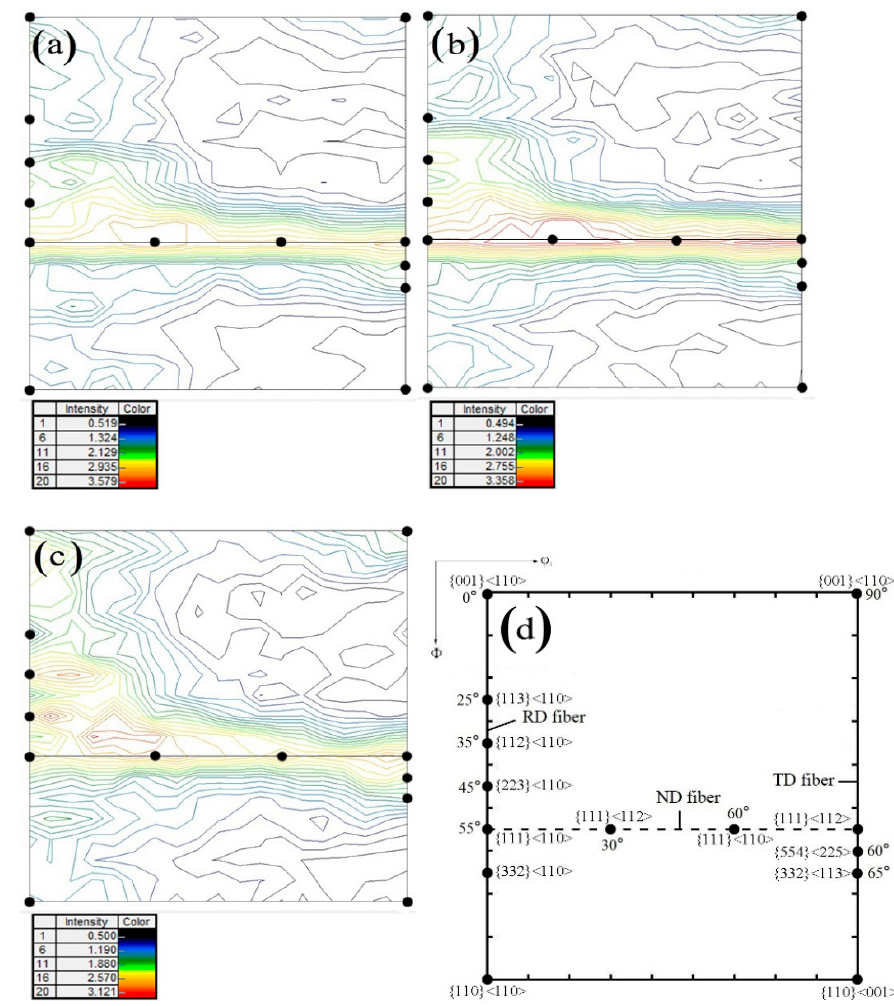
Figure 3. ODF sections ( φ 2 = 45°) with different secondary cold reduction rates: ( a ) 15%, ( b ) 20%, ( c ) 25%, ( d ) the important orientation positions.